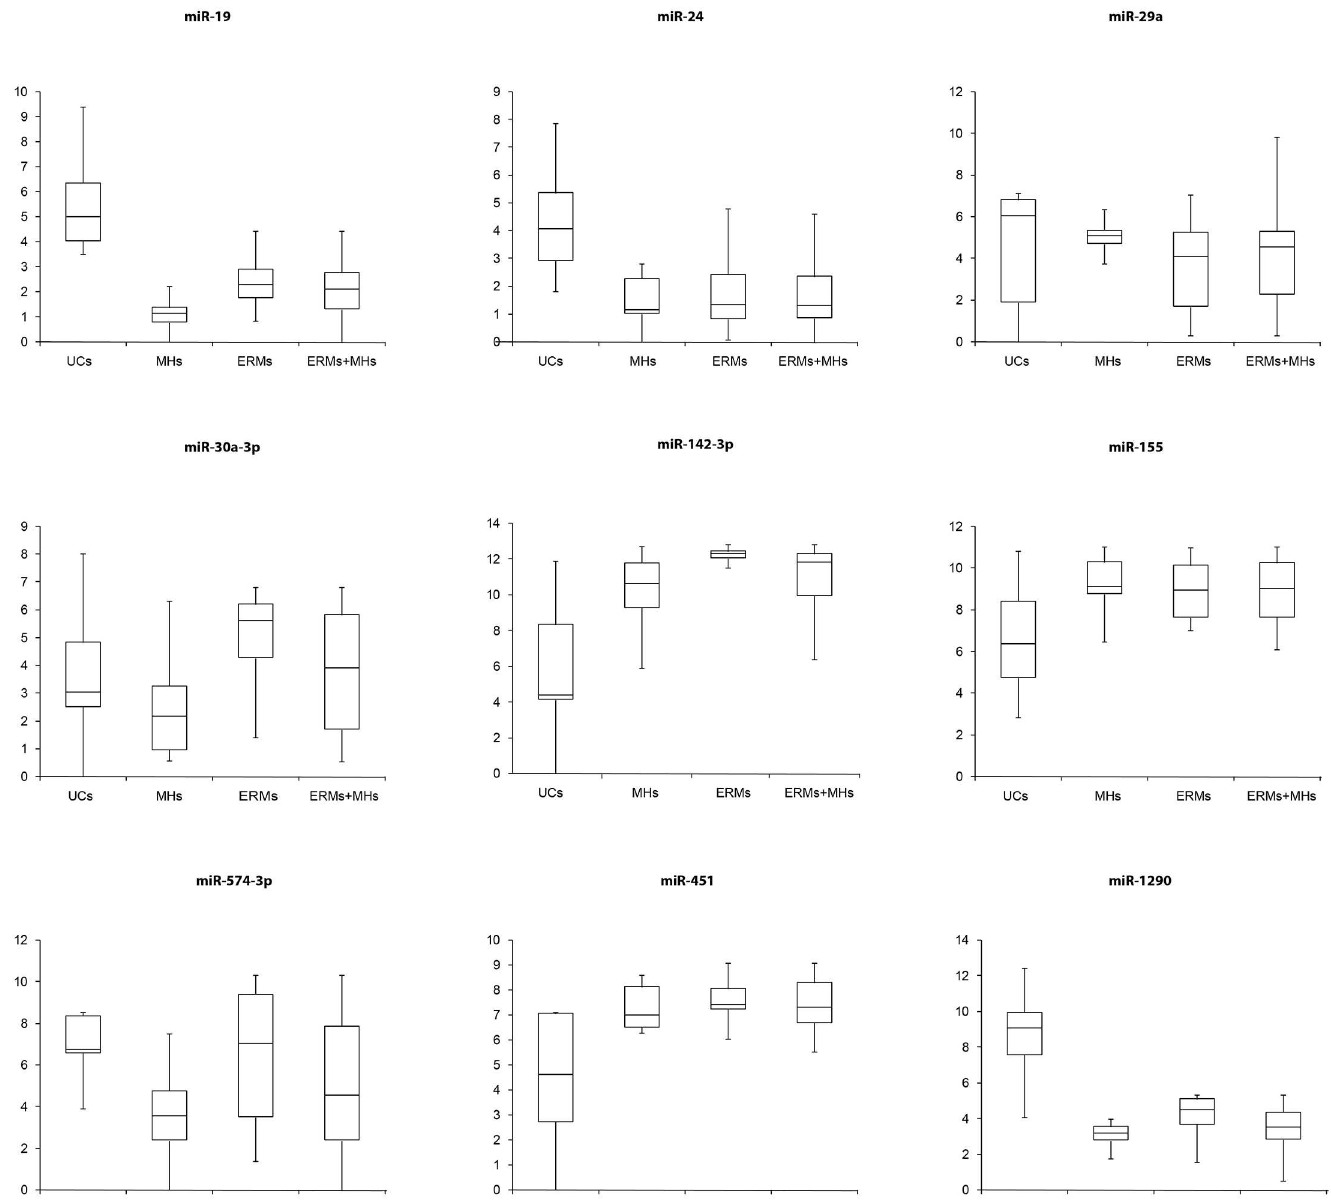
Fig 1. Box Plots of differentially expressedmiRNAs. Box Plots from SingleTaqMan ® Assays on TaqMan ® Low Density Arrays (TLDA) of differentially expressedmiRNAs. Validation by single TaqMan ® assays of differentially expressedmiRNAs identifiedby TLDAs in the vitreous humor of all the patients and controls. Valueson the y-axis are reportedas Δ Ct × ( −